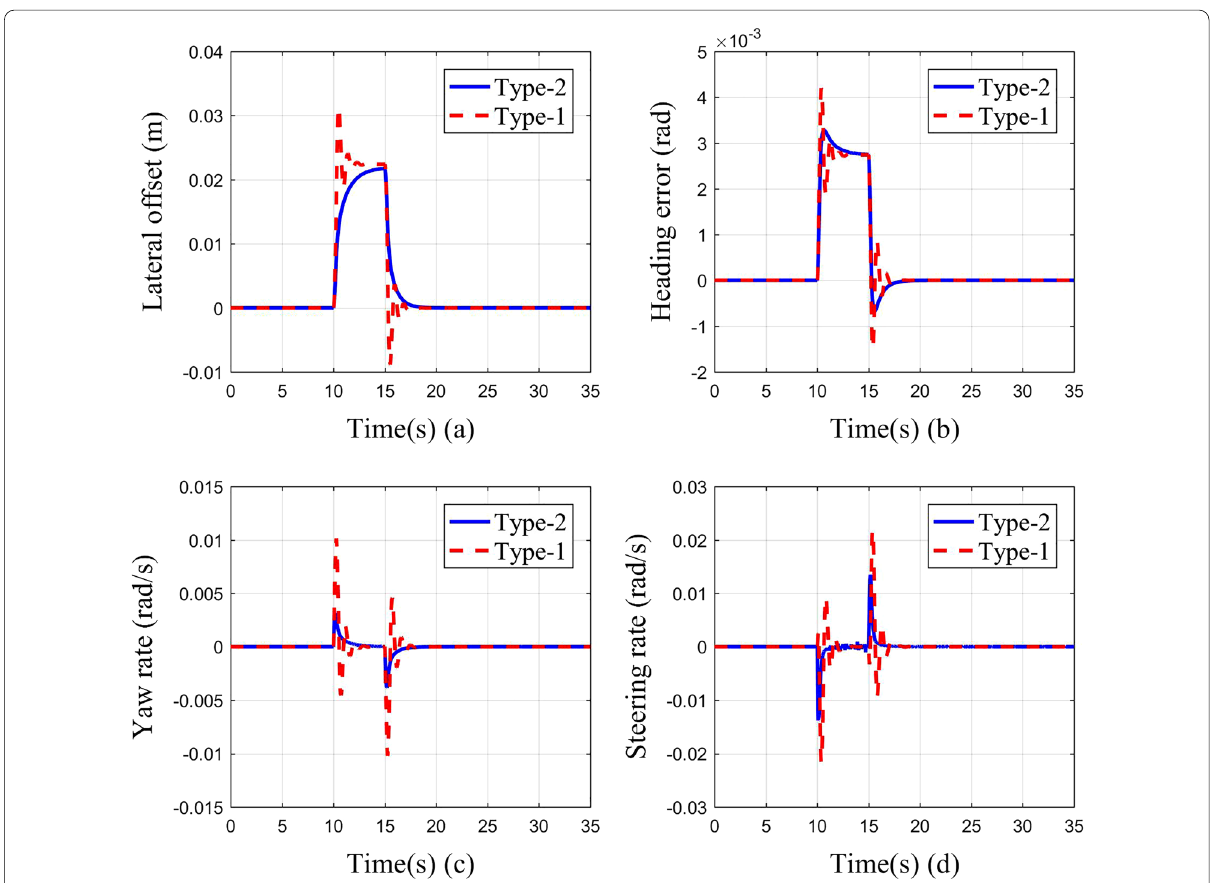
Figure 9 Response of vehicle states in accordance with given road